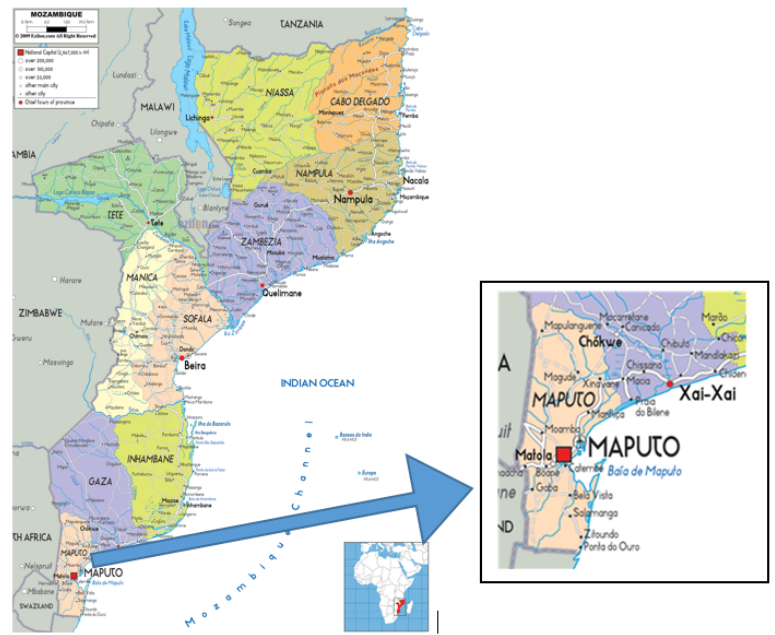
Figure 1. Maps of Mozambique and Maputo province. Source: https://images.search.yahoo.com/search/images?p=mozambique+map&fr=mcafee_uninternational&imgurl=https%3A%2F%2Fwww.nationsonline.org%2Fmaps%2FMozambique_map.jpg#id=2&iurl=http%3A%2F%2Fwww.ezilon.com%2Fmaps%2Fimages%2Fafrica%2Fpolitical-map-of-Mozambique.gif&action=click.